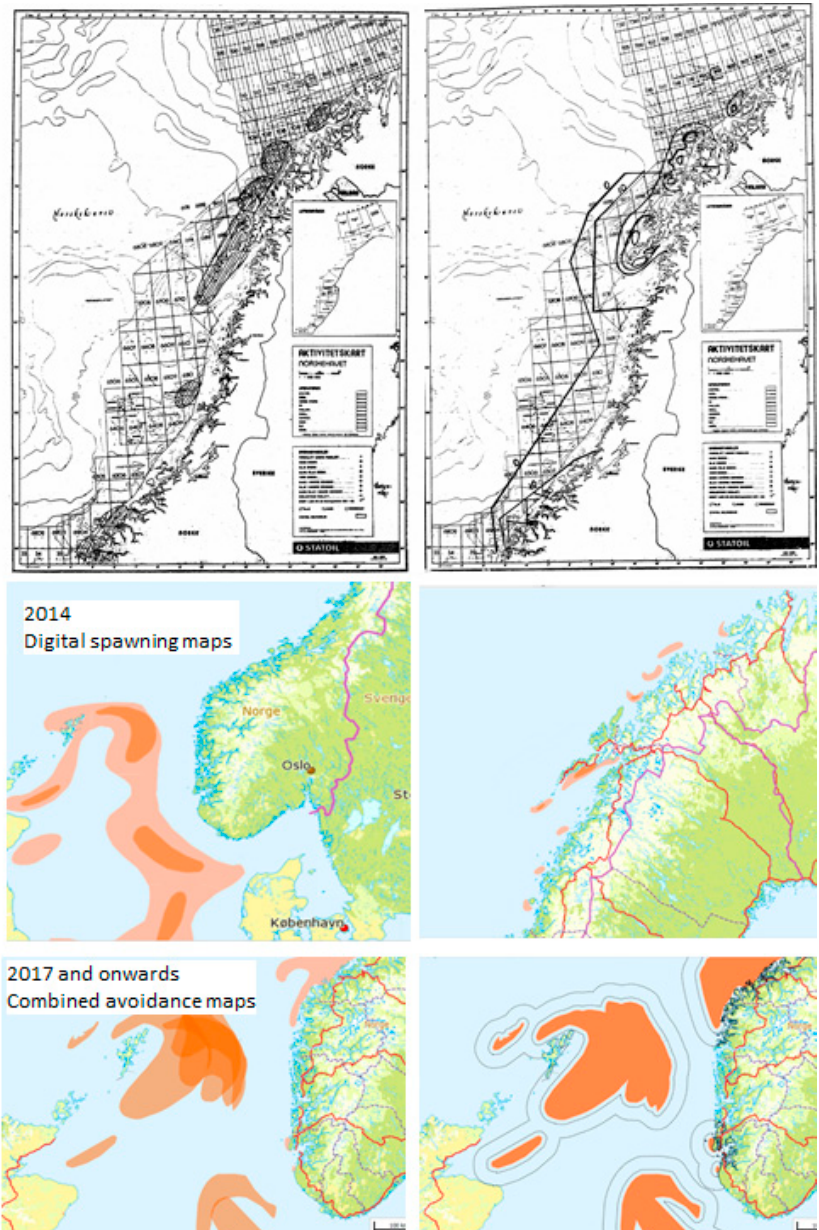
Figure 2. Upper panel : Examples of maps of spawning areas of and of areas of drifting eggs and larvae, as used to give advice in the period 1991 to 2014 [72]. These maps only existed in paper format. Left : Spawning areas for cod, with restriction periods between 15 March and 15 May. Right : Drifting cod eggs. Restriction periods between 1 April and 30 April. The restriction on drifting eggs and larvae ended in 1996, while the restrictions on the spawning areas still hold, but the exact area and period have been updated. Middle panel : Digital spawning maps available from 2014. Areas divided into important and less important spawning areas. This example is for cod, with darker areas being the most important ones. The important restrictions are applied in(dark) areas. Right : North Sea cod. Left : Northeast Arctic cod. Lower panel : Spawning maps for each 2 week period of the year merged into maps with restriction areas. Left : Important spawning maps for different North Sea fish species (cod, Norway pout, saithe, herring). Right : Avoidance map for period 1 to 15 March. These are made by combining all the maps for important spawning areas for those fish that spawn in this period (which are those shown on the map to the left), as well as two buffer zones (dotted lines) of 5 and 20 nmi, and the advised restrictions for site surveys and regular seismic surveys,